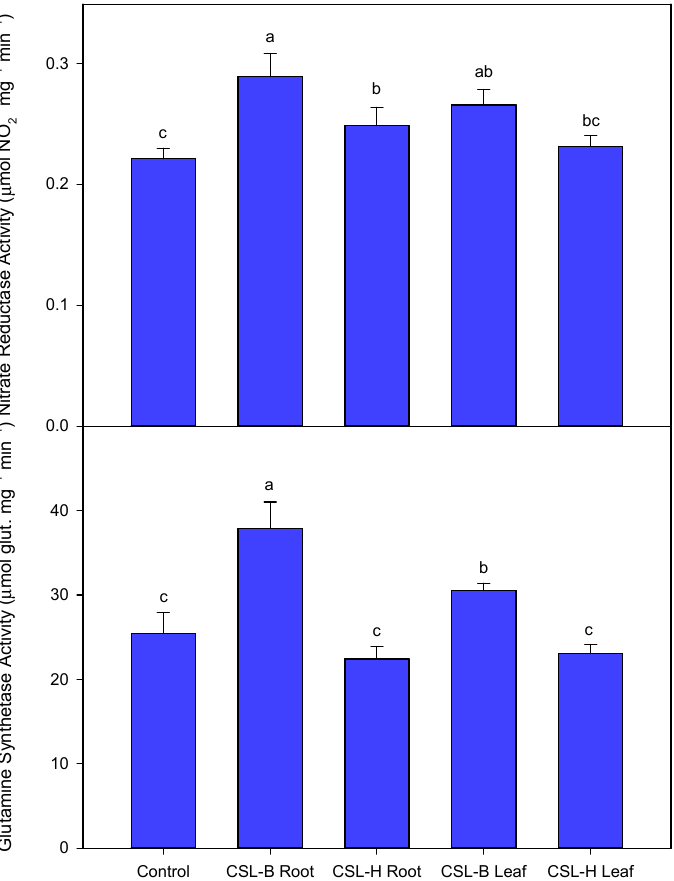
Figure 2. Activity of nitrate reductase (NR) and glutamine synthetase (GS). The values represent the means ± standard deviation (SD) for n = 3. The differences between the treatments were analyzed with Fisher’s least significant difference test (LSD; p = 0.05); in each graph, significant differences between treatments at p < 0.05 are indicated. In the ANOVA, the significance level is represented by p < 0.001 (***). Table 6. Aminogram of each of the treatments tested in this experiment. The data are from the last sampling, 7 days after the last application of the